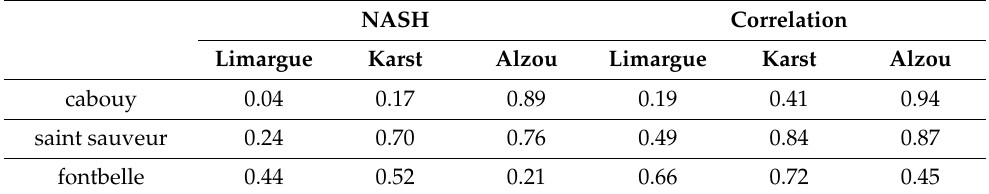
Table 5. Comparison between the contribution curves of the mobile and fixed origin mixing model. NASH